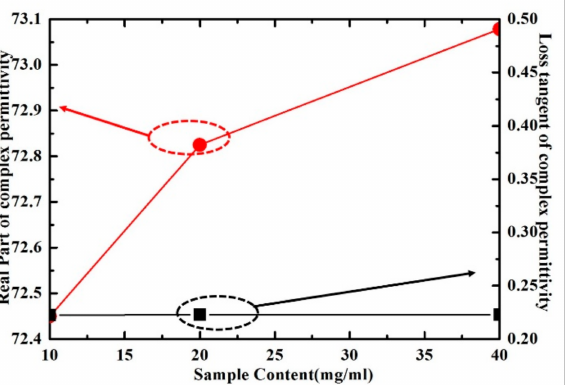
Figure 16. Measured results of real part and loss tangent of inositol solution with different concentra- tion at the frequency of 5.05